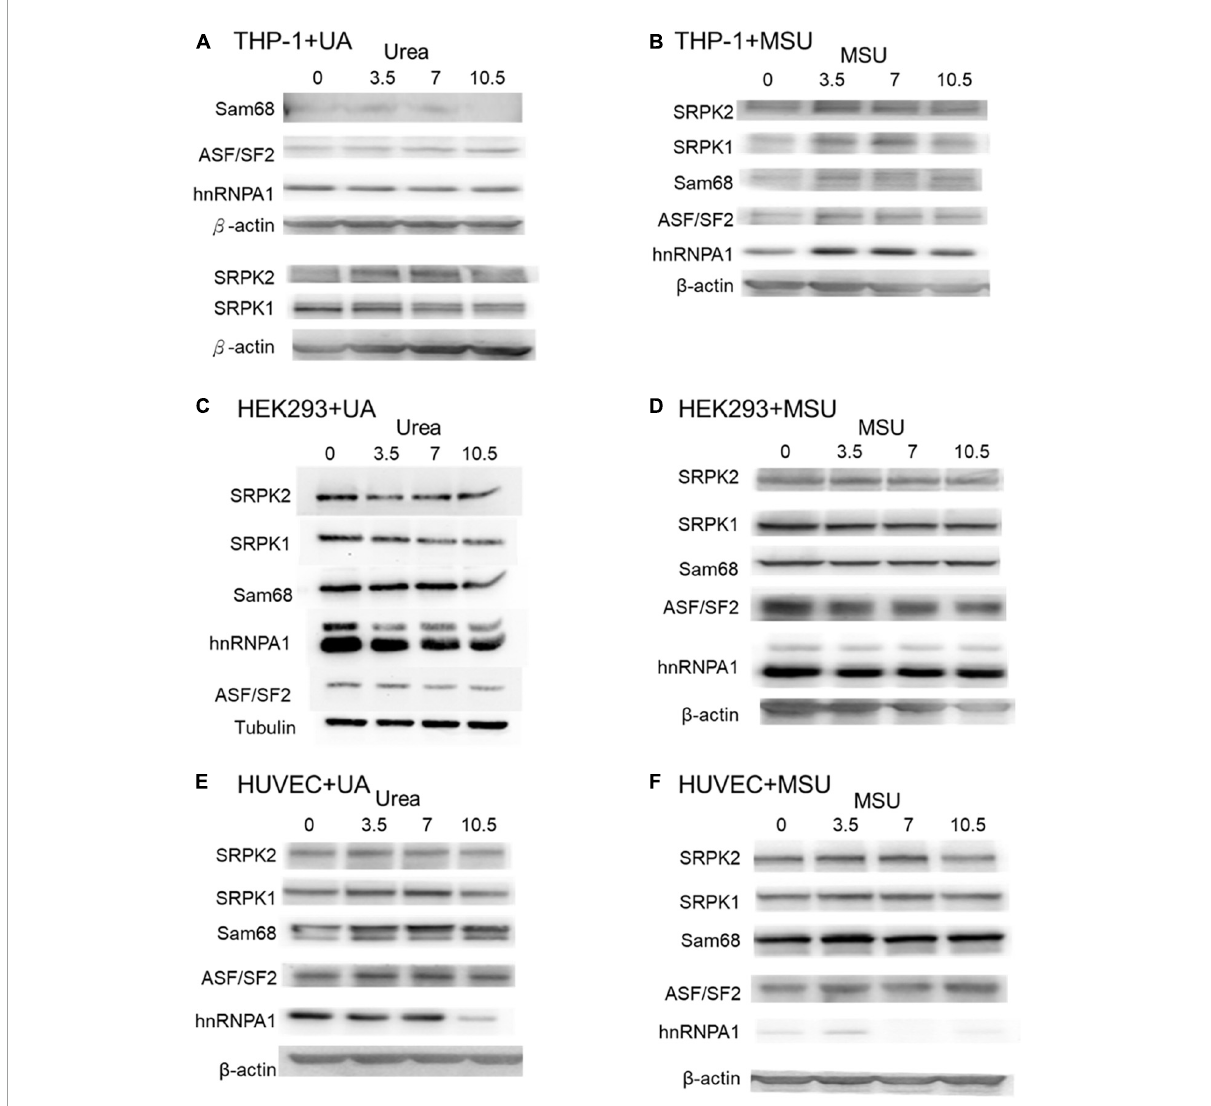
FIGURE8 Protein expressions of splicing factors were affected in MSU- or UA-treated cell lines. The expressions of Sam68, ASF/SF2, hnRNPA1, SRPK1, and SRPK2 were detected through Western blotting in UA-treated THP-1 cells (A) , MSU-treated THP-1 cells (B) , UA-treated HEK293 cells (C) , MSU-treated HEK293 cells (D) , UA-treated HUVEC cells (E) , and MSU-treated HUVEC cells (F) . β -actin and tubulin served as the internal control. Representative results from three independent experiments are